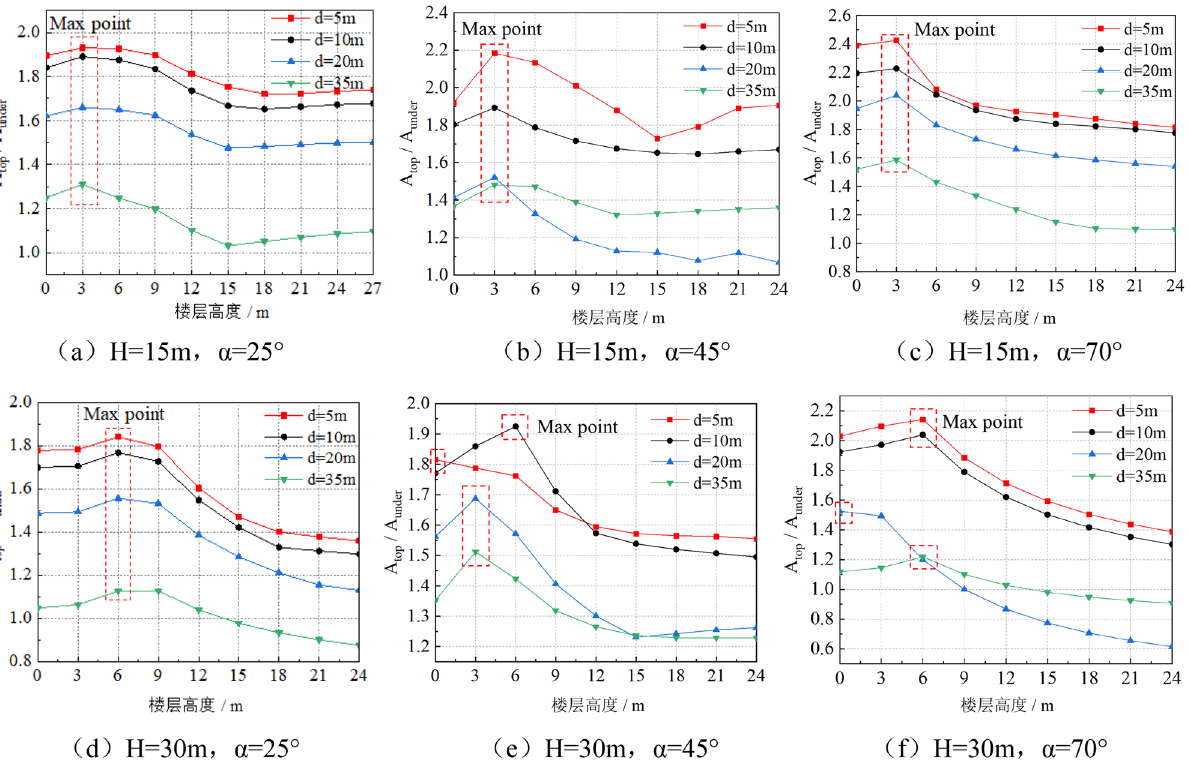
Figure 5. the relative variation law of the acceleration ratio of the top building and the under building along the building